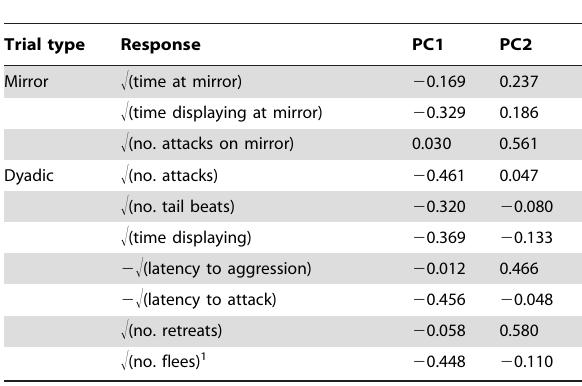
Table 3. Loading coefficients for the first two principal components of the within-individual correlation matrix among repeatable